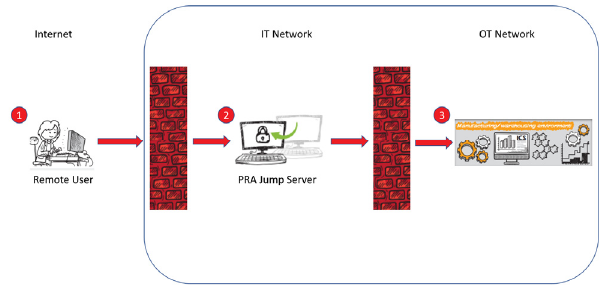
Figure 13. Privilege Remote Access management .